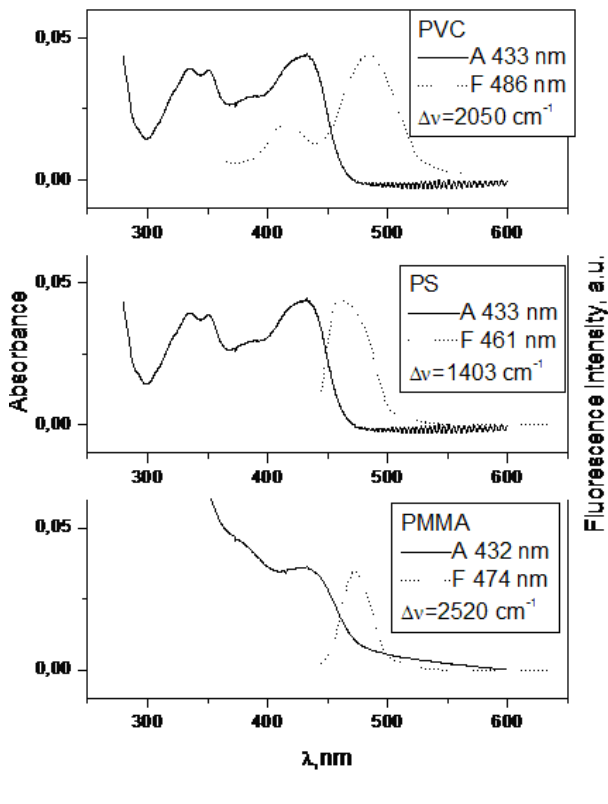
Figure 7. Absorption and fluorescence spectra of 1 in PMMA, PS, PVC at 0.002 mol kg − 1